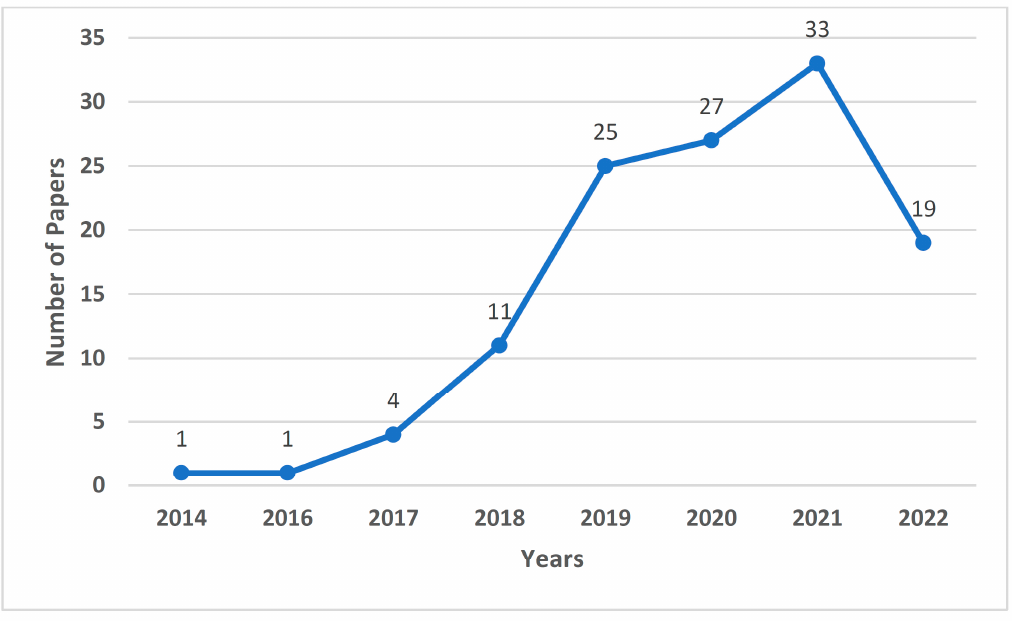
Figure 2. Number of papers per year, used in the review.